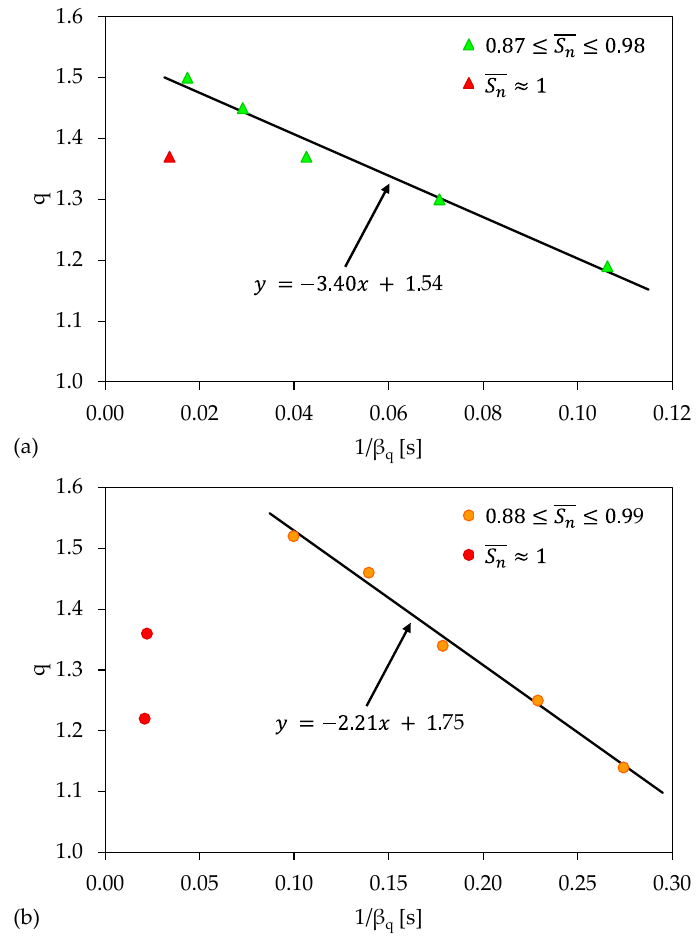
Figure 9. The values of the entropic index q as a function of the parameter 1/ β q for the UC protocol, ( a ) for the stages of stress jumps; ( b ) for the stages when the stress was kept constant.